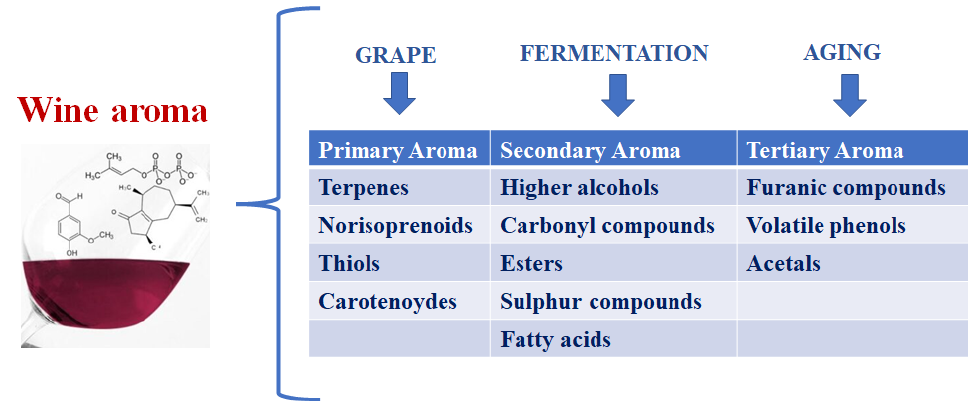
Figure 1. Subdivision of the wine aroma complexity according to its origin.